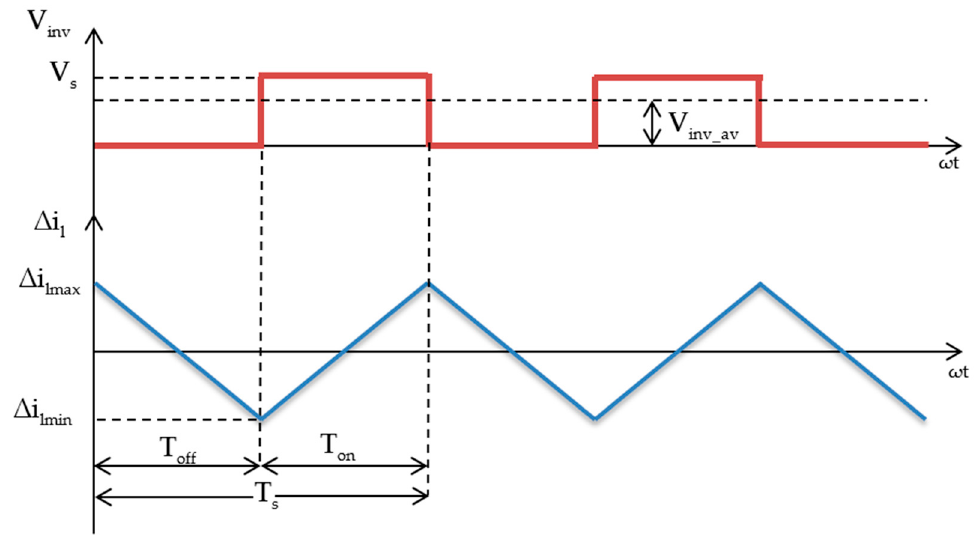
Figure 3. Inverter output voltage and inductor current waveforms during one switching cycle. The inverter switching frequency is usually greater than the system output frequency. Hence, the average value of the inverter output voltage can be treated constant during the switching period T s